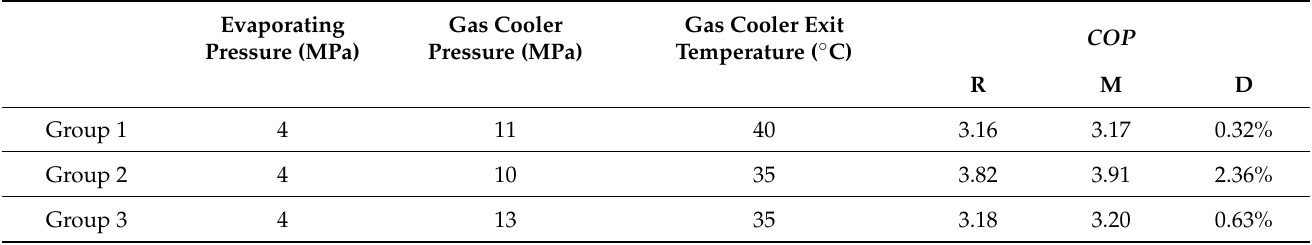
Table 5. Comparison of the calculated values of thermal efficiency of the ORC system obtained by system modeling with the corresponding values reported in the literature [40]. (R: reported; M: modeling; D: difference).